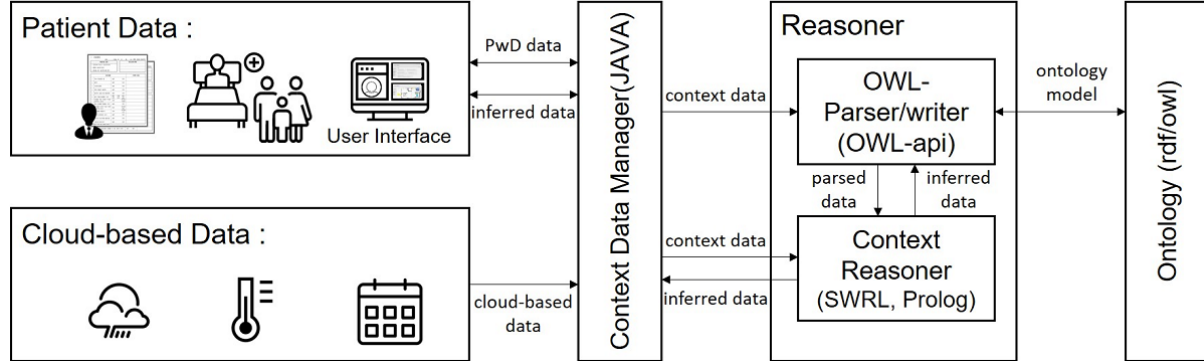
Figure 5. Overall architecture of the care knowledge management system. OWL: Web Ontology Language; PwD: persons with dementia; SWRL: Semantic Web Rule